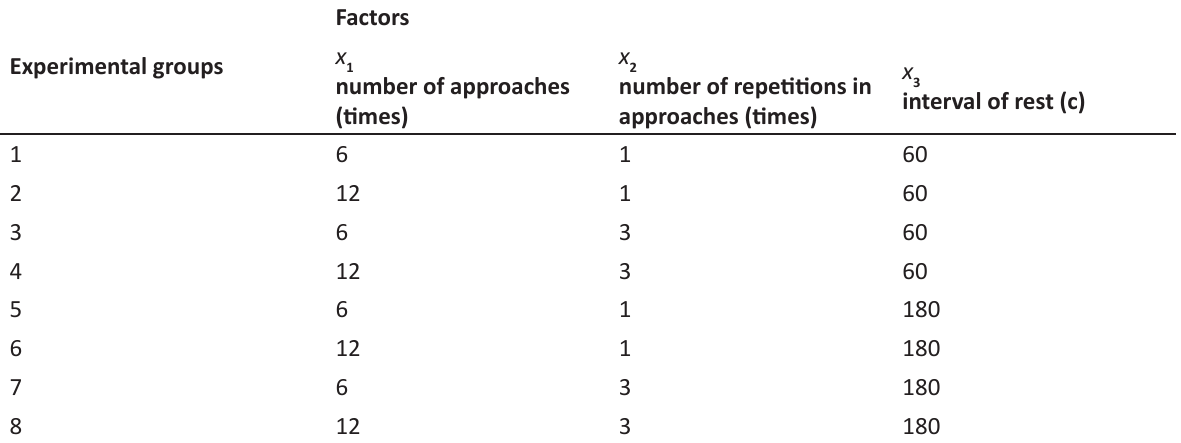
Table 1. Matrix of the factor experiment of type 23 in the study of influence of different modes of repetition exercises on their level of training